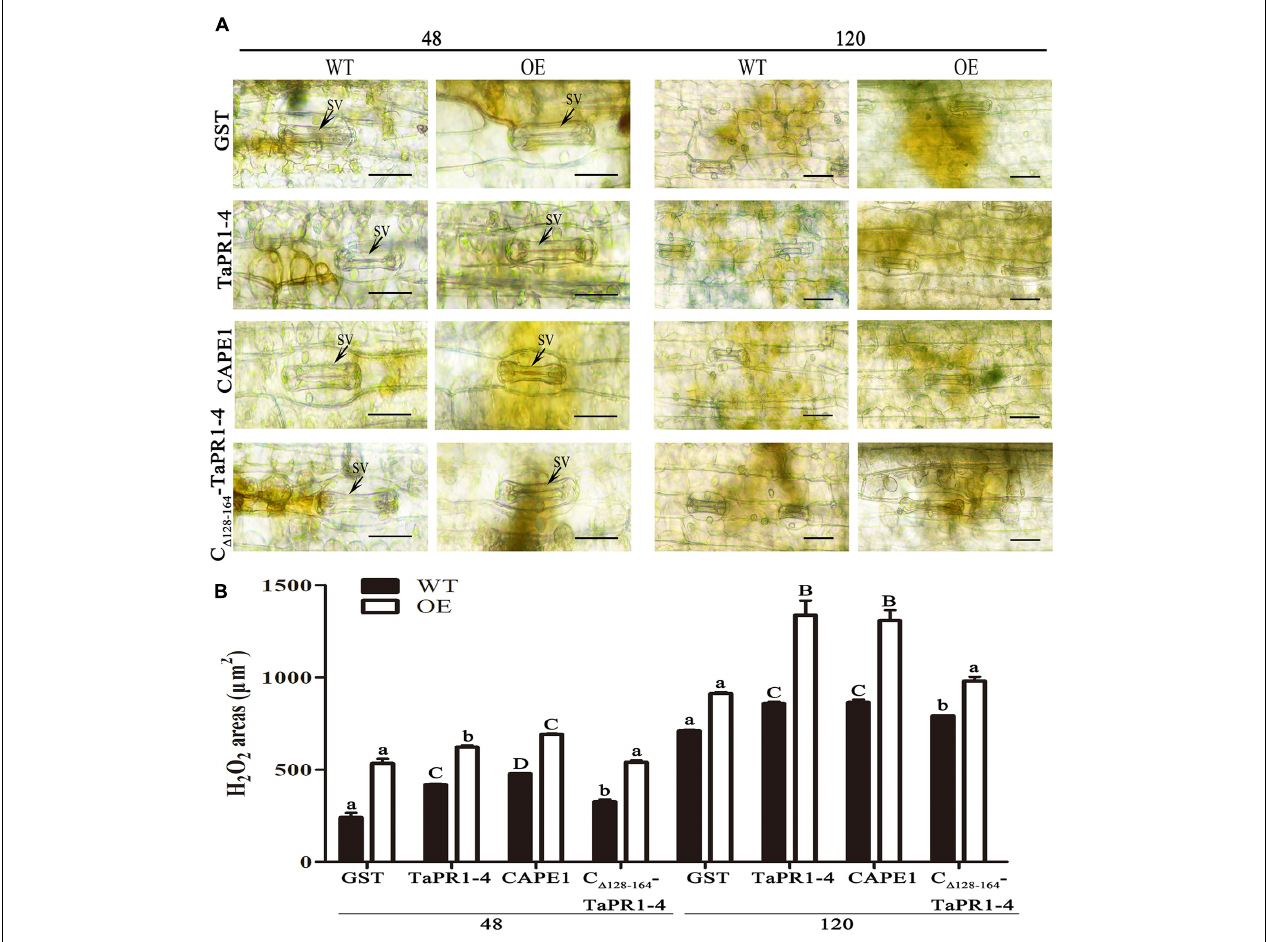
FIGURE 7 | H 2 O 2 production and necrosis were observed in these leaves at 48 and 120 hpi. (A) H 2 O 2 accumulation at infection sites was detected by staining with DAB and viewed under differential interference contrast optics. GST, TaPR1-4, CAPE1 and C (cid:49) 128 − 164 -TaPR1-4 (0.1 mg/ml) were infiltrated into first and second leaves of TaTLP1-OE and WT lines. WT, JW. Scale bar, 20 µ m. (B) ImageJ software was employed to quantify the H 2 O 2 area. A minimum of 50 infection sites were examined. Values are means ± SEM of three independent biological replicates. Significant differences were assessed using one-way analysis of variance (ANOVA) and Duncan’s multiple range test (DMRT) with p <